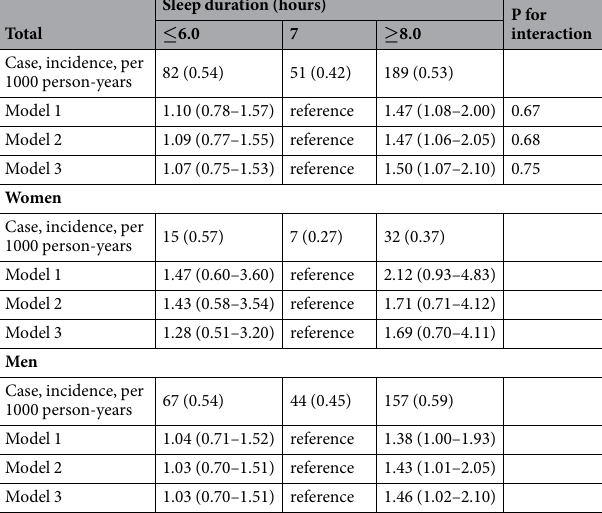
P for interaction ≤ 6.0 ≥ 8.0